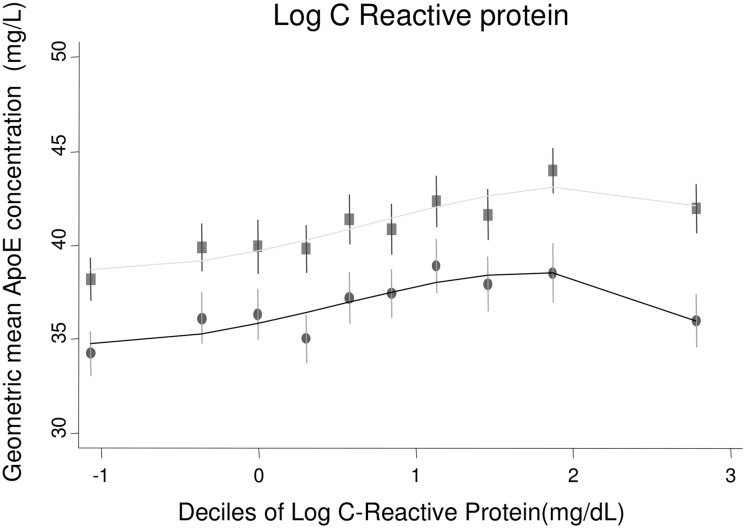
Cross-sectional association between geometric mean of ApoE concentration and C-reactive protein measured in ELSA, by gender.Male (circles) and female (square) mean log ApoE concentration was calculated for each decile of the associated variable and plotted to visualise the shape of the association. Bars give 95% CIs.